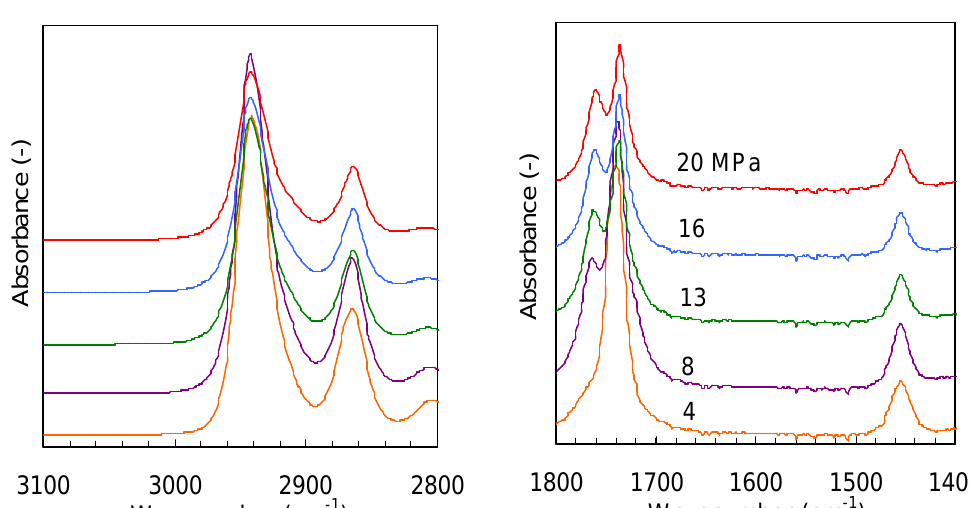
and dense CO at different pressures 2 2